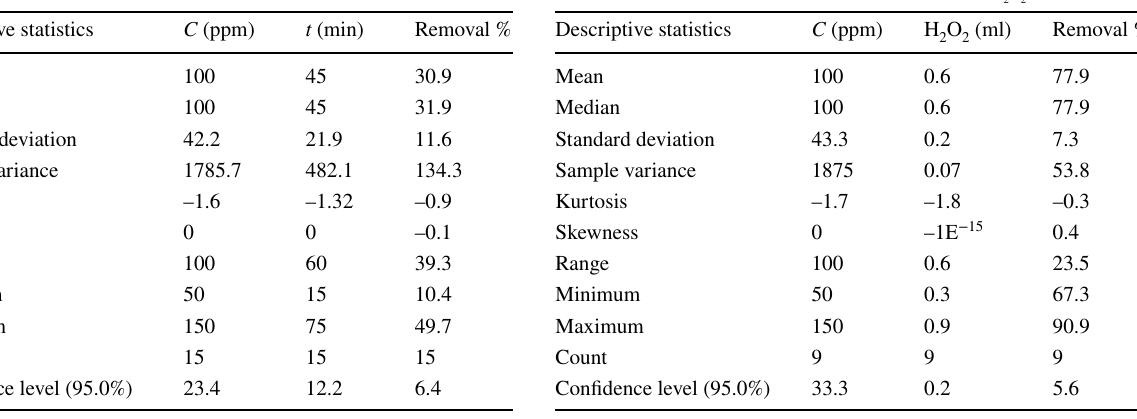
Table 1 Descriptive statistics of the data used for R